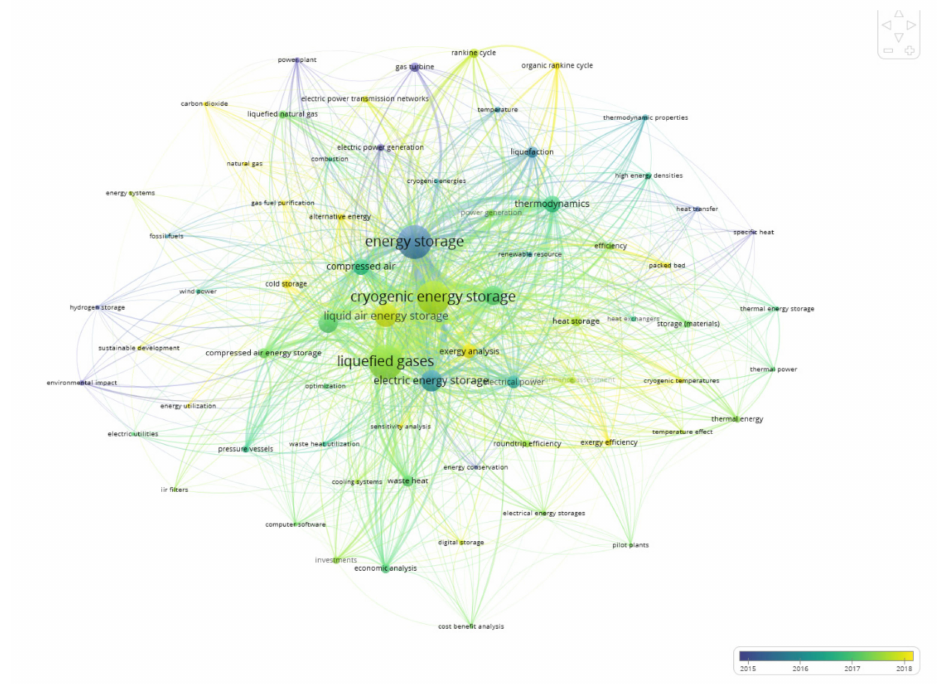
Figure 16. Co-occurrence and overlay visualization of the keyword elaborated with